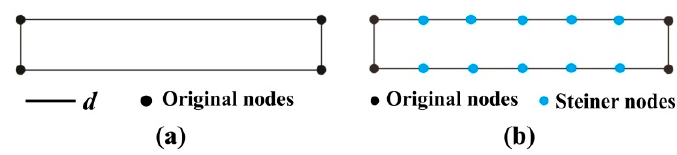
Figure 7. Adding Steiner nodes: ( a ) Original nodes of area elements and ( b ) Steiner nodes.